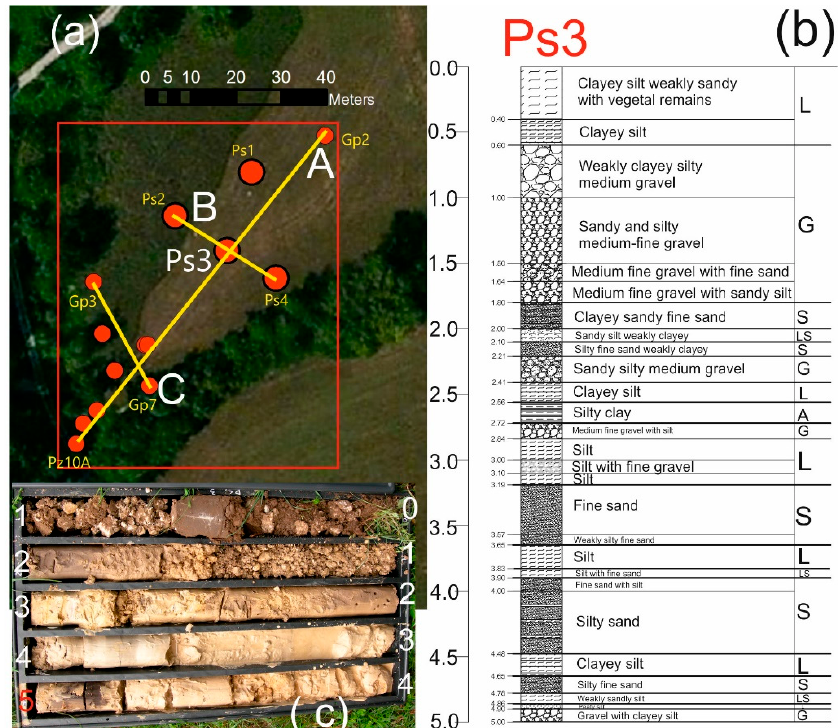
Figure 2. ( a ) Location of 13 piezometers (red dots); simulated area (red rectangle); traces of cross sections (yellow lines) (image from Google Earth); ( b ) stratigraphy of Ps3 with example of lithologic reduction to 5 materials; ( c ) core box of Ps3 piezometer.